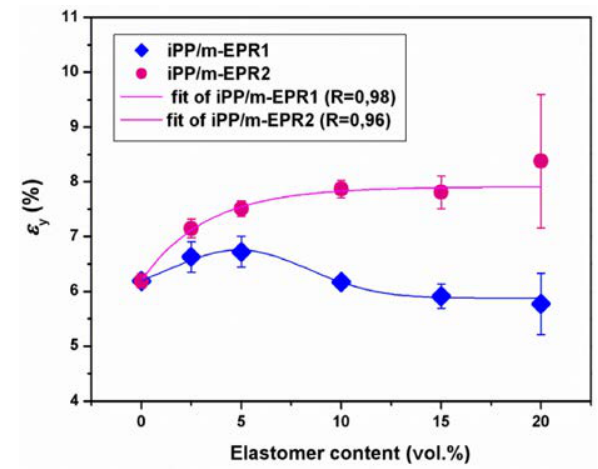
Figure 4. Elongation at yield of the iPP/m-EPR blends in depend- ence on volume content of added